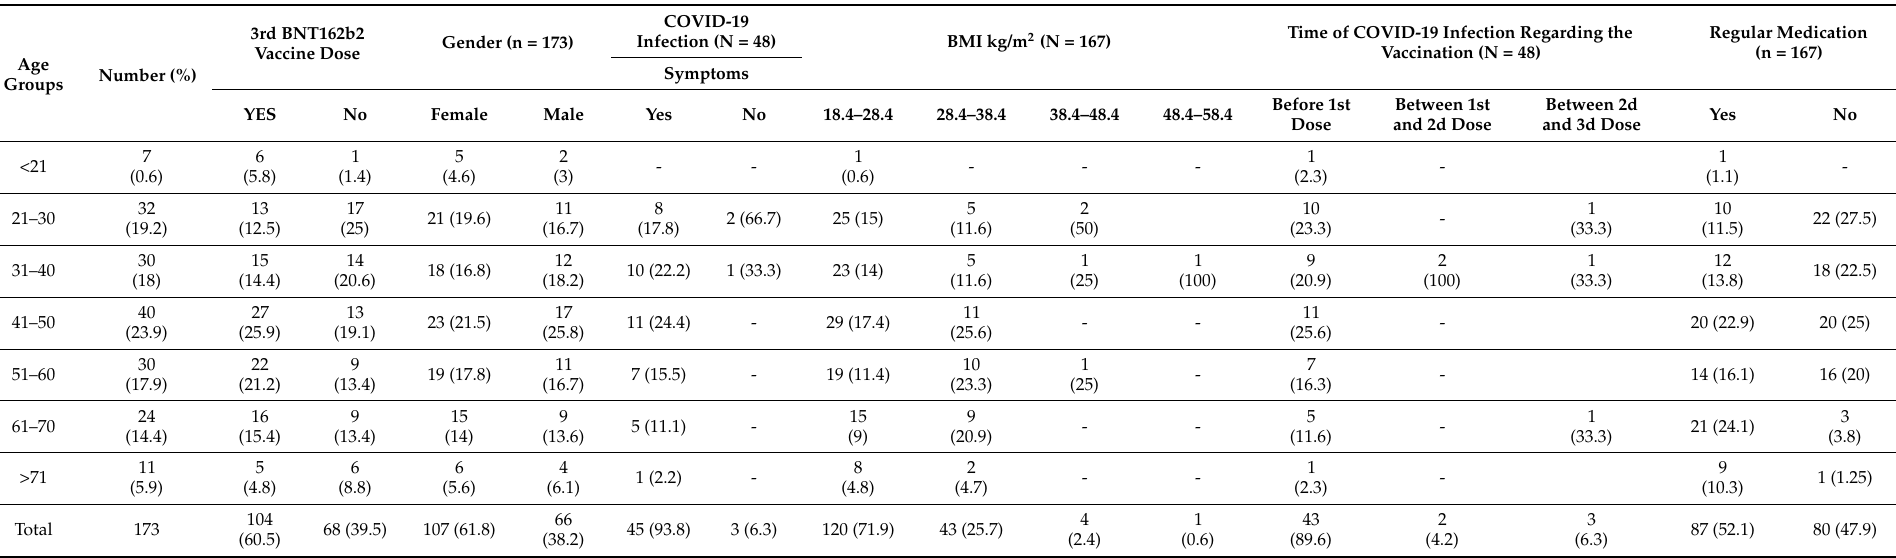
Table 1. Distribution of baseline characteristics, vaccination status and COVID-19 infection history among healthcare workers [quantitative data are presented as number (%)].